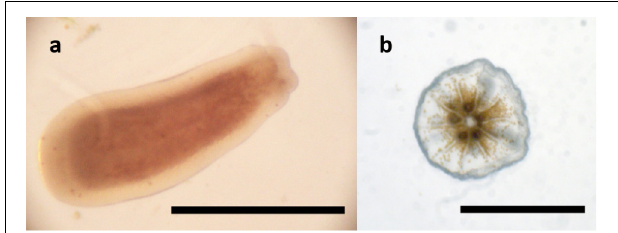
FIGURE 5 | Planula of Leptastrea purpurea (a) and primary polyp (b) . Scale bar: 0.5 mm.